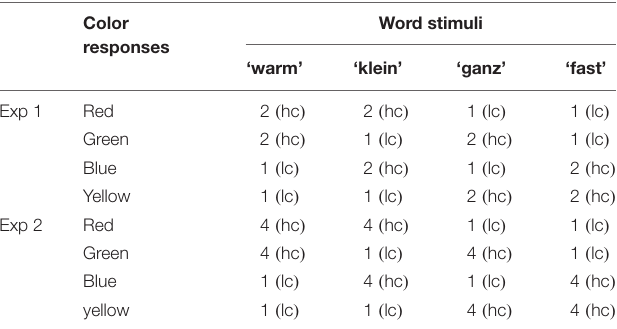
TABLE 1 | Example for word-color contingency manipulation in Experiments 1 and 2. Color